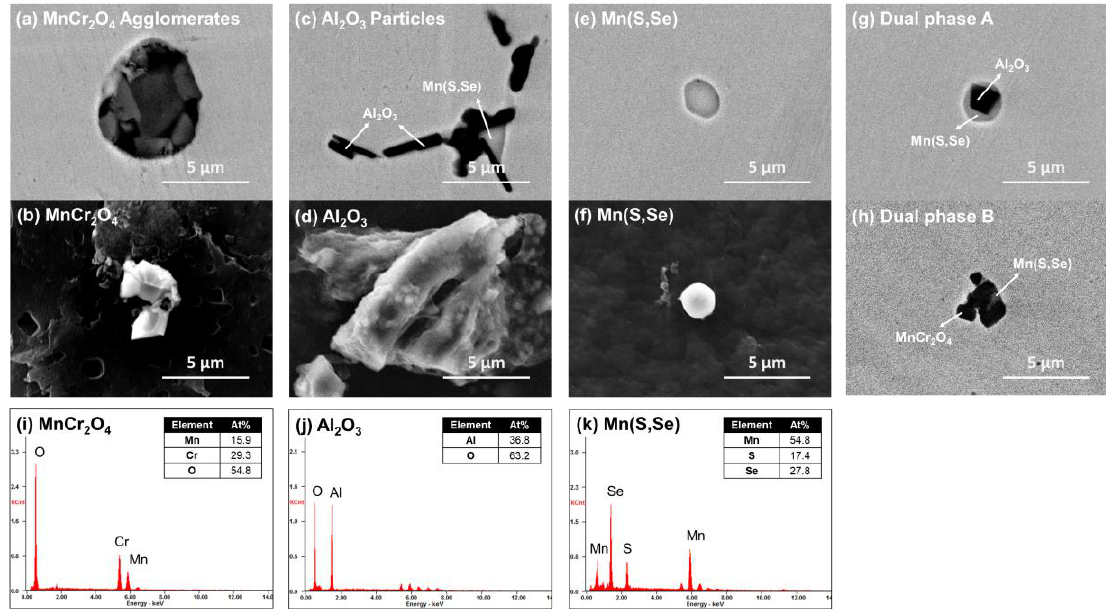
Figure 2. Representative morphologies and chemical composition for types of inclusions. ( a , c , e , g , h ) 2D and ( b , d , f ) 3D morphologies, and ( i – k ) energy dispersive X-ray spectroscope (EDS) peaks.